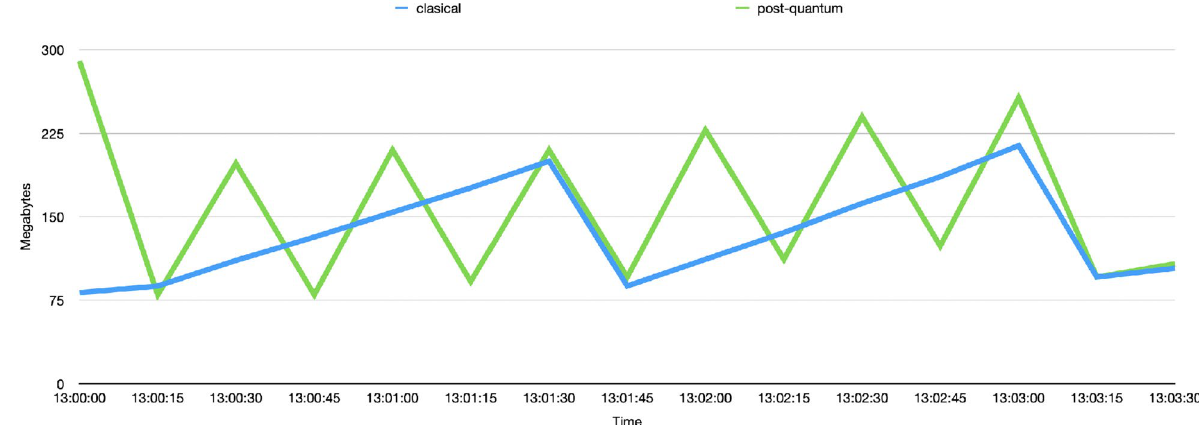
Figure 13. Comparison between the use of memory in the classical and post-quantum scenarios when sending 5